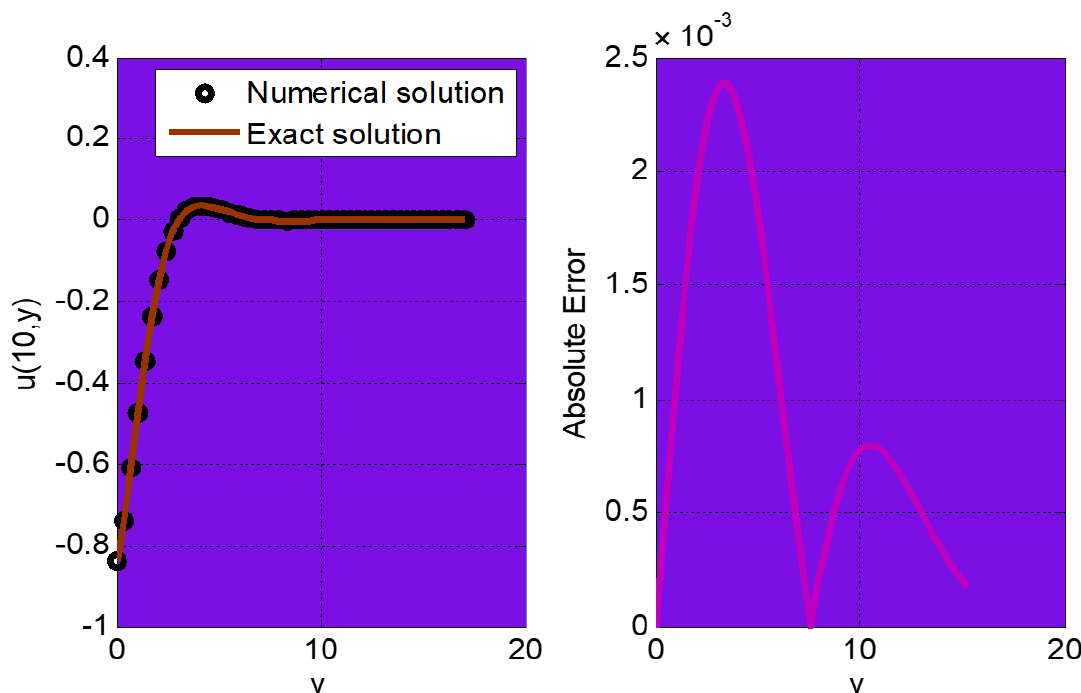
Figure 6. Velocity profile and absolute error for Stokes’ second problem in Quantum Calculus by the proposed scheme for spatial direction and Crank–Nicolson scheme for time direction using N y = 50, N t = 300, t f = 10.